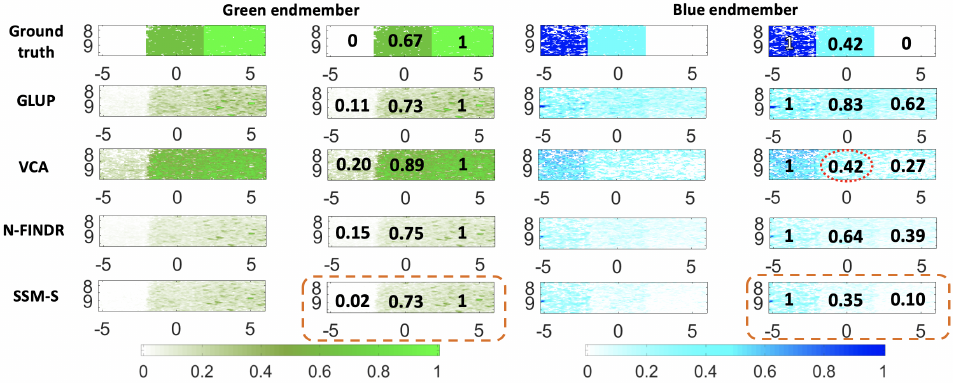
Figure 10. Unmixing method results for the B-mix-G(Vevo) dataset with the algorithms indicated, combined with FCLS. Left columns: green endmember and unmixing results summary. Right columns: blue endmember and unmixing results summary. The values in black are the average normalized values as explain in Figure 5. The ground truth is shown in both cases, in the first row. The image axes are in